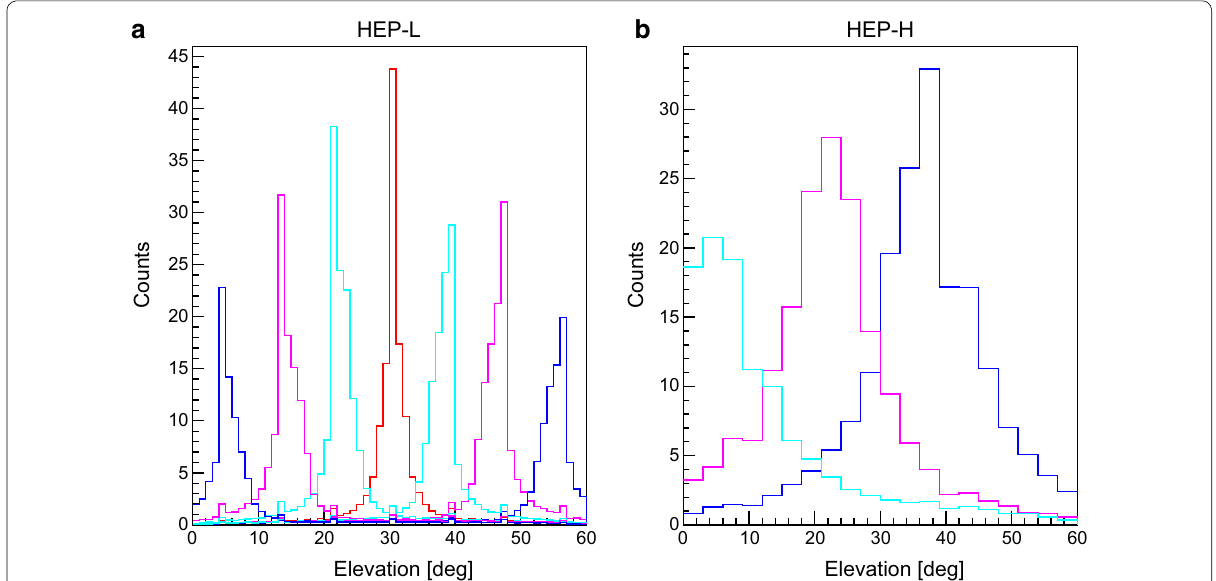
Fig. 11 Angular response measured with HEP flight model. a Angular responses measured while changing the beam incident angle on HEP-L (i.e., rotating HEP around X sc -axis in Fig. 1); bin width is 1°. b Angular responses measured when changing beam incident angle on HEP-H (i.e., rotating HEP around X sc -axis in Fig. 1); bin width is